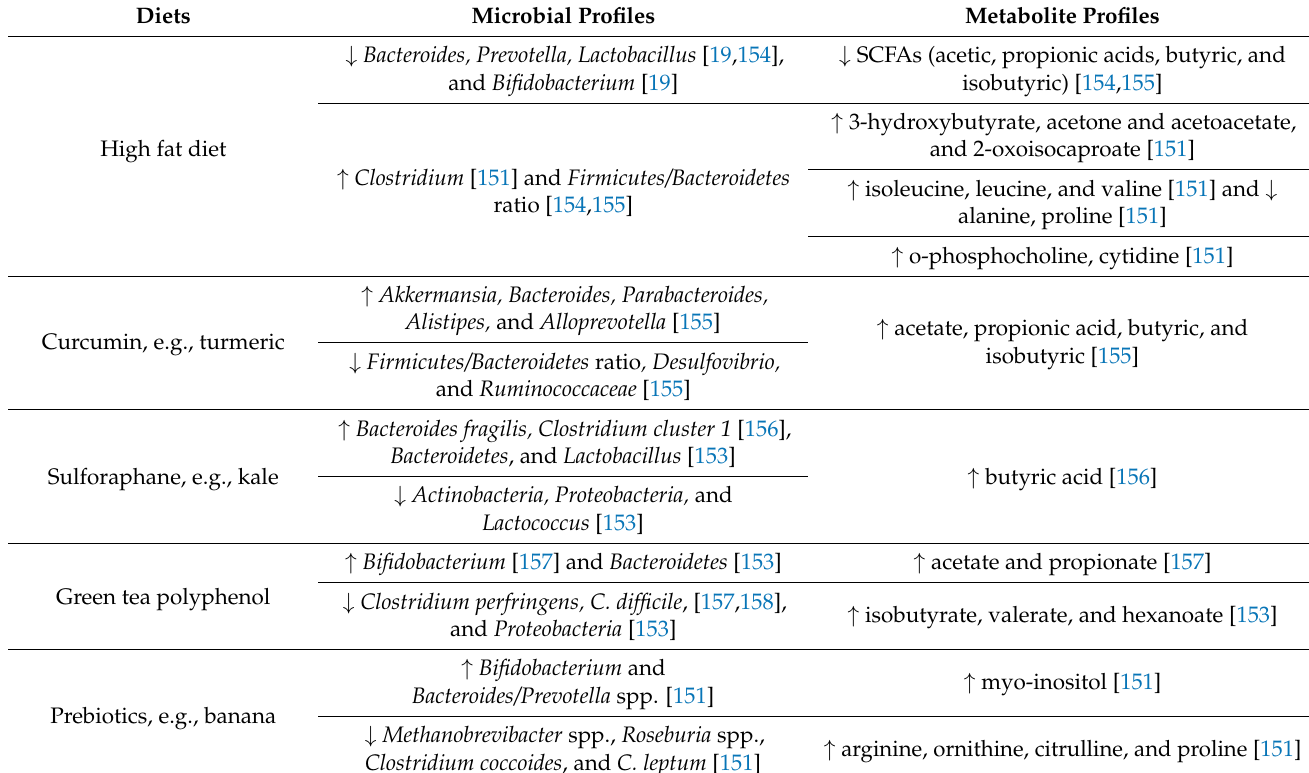
Table 1. Effects of bioactive dietary components on gut microbial and metabolite